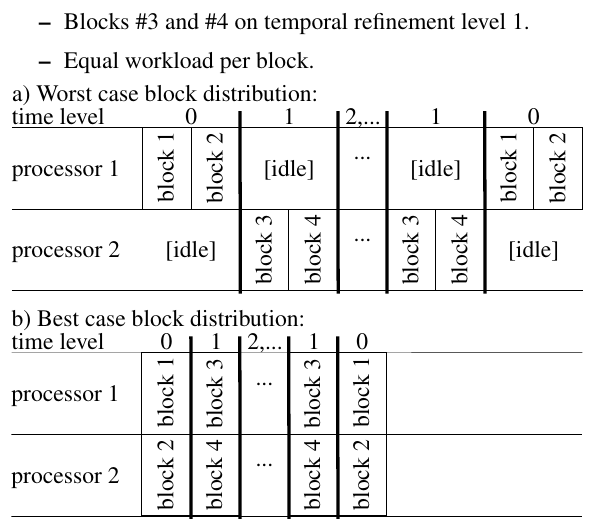
Fig. 5. Parallel program flow for different distributions of four blocks on two processors. Thick lines indicate exchanges.